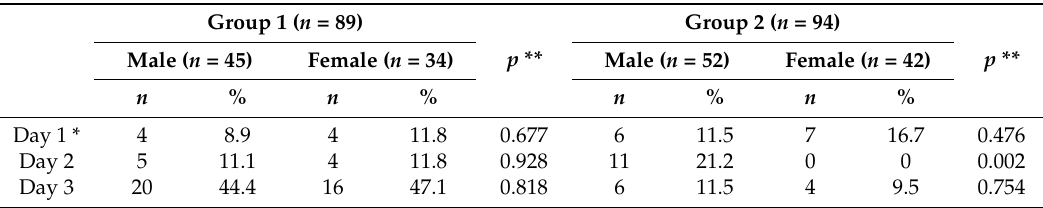
Table 4. Percentage of students at the University Restaurant who consumed over four hundred grams of fruits and